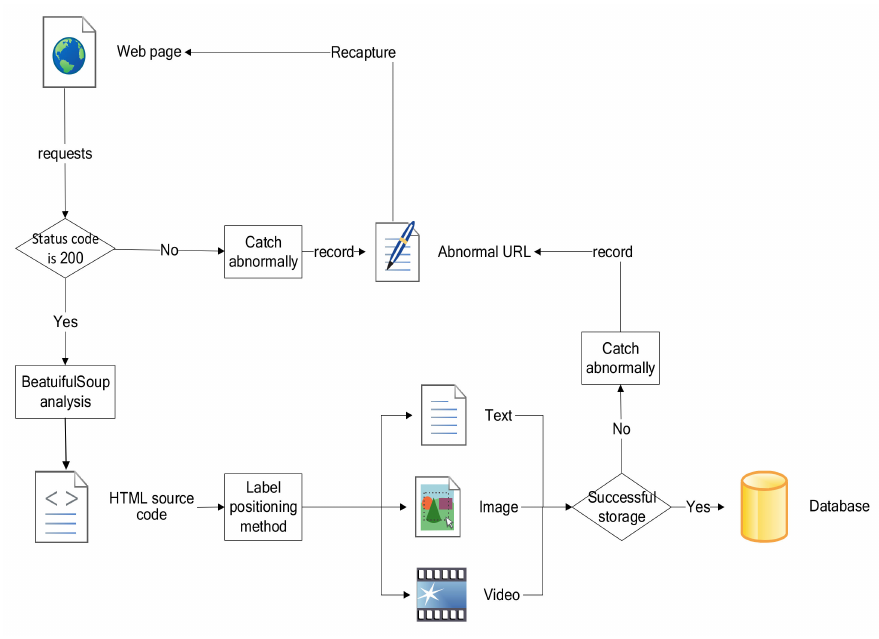
Figure 1. Data collection process of YiXi